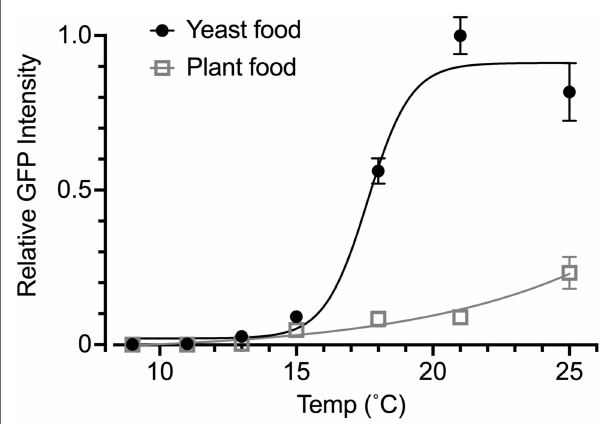
FIGURE 4 | Effects of food quality on temperature-response relationships. The GFP fluorescence intensity was used to measure the yolk content in the ovary of animals fed yeast food or plant food throughout the larval and adult stages. The rearing temperature was 25 ° C in the larval stage for all tested individuals. The flies were then kept at the indicated temperature at eclosion for 1 week. The curves are four parameter logistic curves with the maximum of 19.64, the minimum of − 0.025, IC 50 of 53.26 and the slope factor of 0.067 for the plant food group (open triangles and grey line) and the maximum of 0.911, the minimum of 0.02, IC 50 of 17.61 and the slope factor of 0.549 for the yeast food group (filled circles and black line). The animals were kept under the photoperiod of L/D: 12/12 throughout the experiment. The genotype of flies: Yp1::GFP/+ . The mean ± SEM are shown. n =